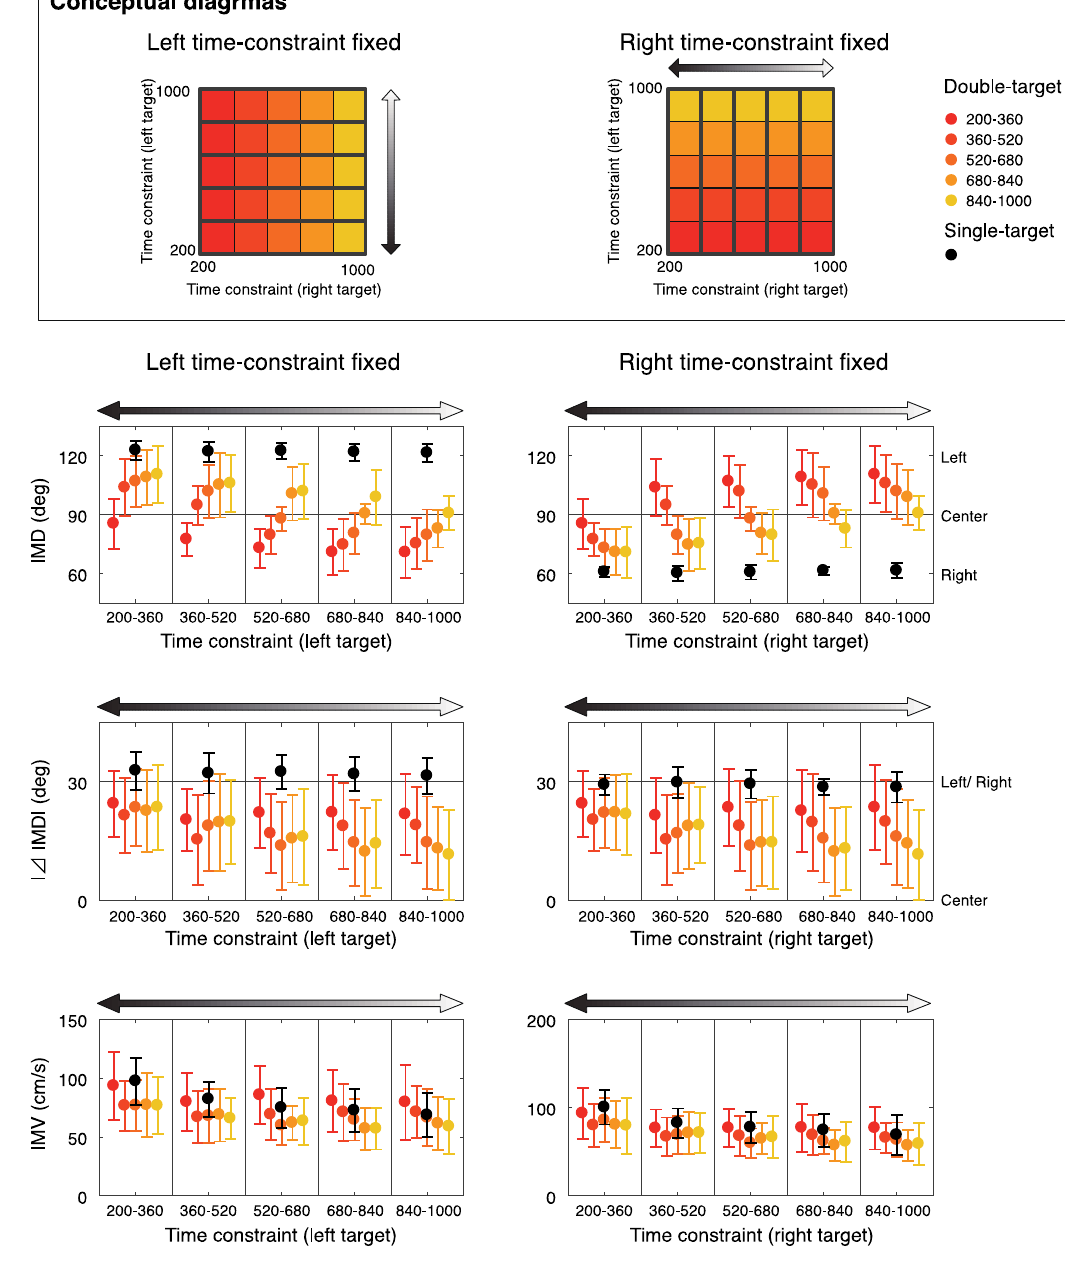
Figure 5. Comparison of the initial movement behavior among conditions. The upper, middle, and lower panels show inter-condition comparisons of the IMD, IMV, and | ⊿ IMD|, respectively. The circles and error bars show the means and standard deviations, respectively. The black-colored circles show the data for the single- target condition, and gradient circles from red to yellow show the data for the double-target condition. The horizontal axis of the left (/right) panel is classified by the level of time constraint of the left (/right) target, and the modulation according to the time constraint of the right (/left) target at each time constraint level is shown as a gradient. The color changes from red to yellow depending on the severity of the time constraint of the other target (red is tight, yellow is speed required 8 . These results indicate that the planning of the initial movement under multiple potential targets reflects the optimization of the task. A recent study reported that motor planning (in particular, preparation of feedback responses) is adjusted in a utility-dependent manner when asymmetry exists in the utility assigned to the target 30 . These studies showed that motor planning may purposefully depend on restrictions of motor execution (e.g., speed and direction) and target information (e.g., value and size). As an extension of the above study, the current study experimentally manipulated the time constraints assigned to each potential target and investigated the modulation of the initial movement according to the